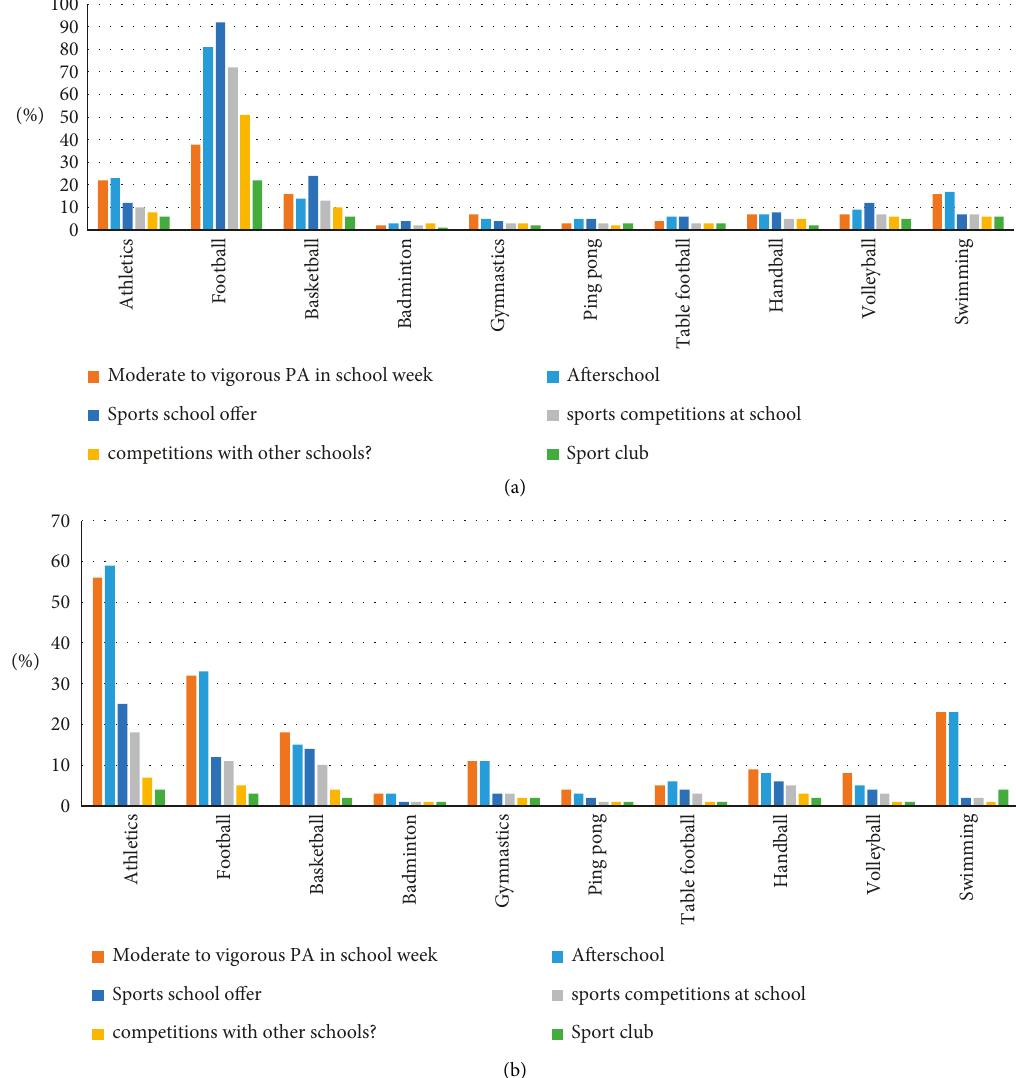
Figure 1: Sports played by students categorised by gender among 1500 adolescents in the KSA: (a) males and (b) females. Table 4: Physical activity, ST, and sleep time during COVID-19 (row percentage) activity among 1500 adolescents in the KSA. COVID-19